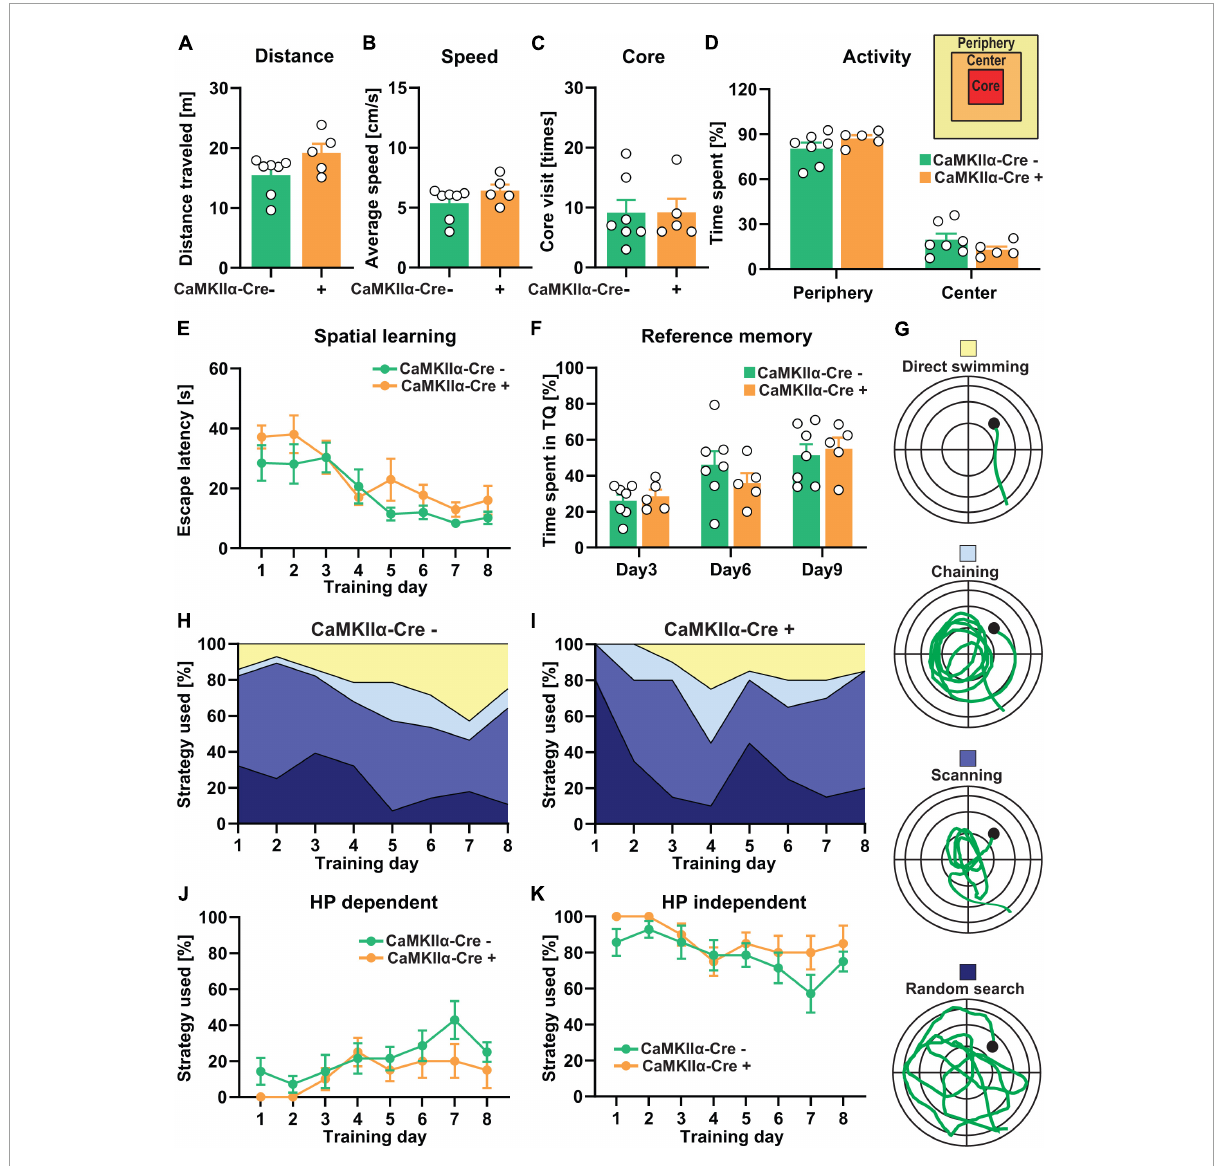
FIGURE5 CA1-specific TTL deletion in the hippocampus does not lead to severe impairment of cognitive functions. (A–D) Total distance traveled (A) , average speed (B) , number of core visits (C) , and percentage of activity of mice in the periphery and the center of the open-field arena (D) showed no significant differences between the TTL lox / lox / CaMKII α − Cre + and control mice. (E–K) In the Morris water maze test, during the 8-day acquisition training, escape latency significantly decreased in both the TTL lox / lox / CaMKII α − Cre + and control groups, indicating spatial learning, but it was not significantly changed between the groups (E) . (F) The percentage of time the TTL lox / lox / CaMKII α − Cre + and control mice spent in the target quadrant did not show significant differences. (G) Different search strategies, including hippocampus-dependent (direct swimming) and hippocampus-independent (random search, scanning, and chaining), were presented and color-coded (H,I) . The TTL lox / lox / CaMKII α − Cre + mice used slightly less hippocampus-dependent (J) and more hippocampus-independent (K) search strategies compared with the control mice. Data are presented as mean ± SEM, N = 5–7 in each